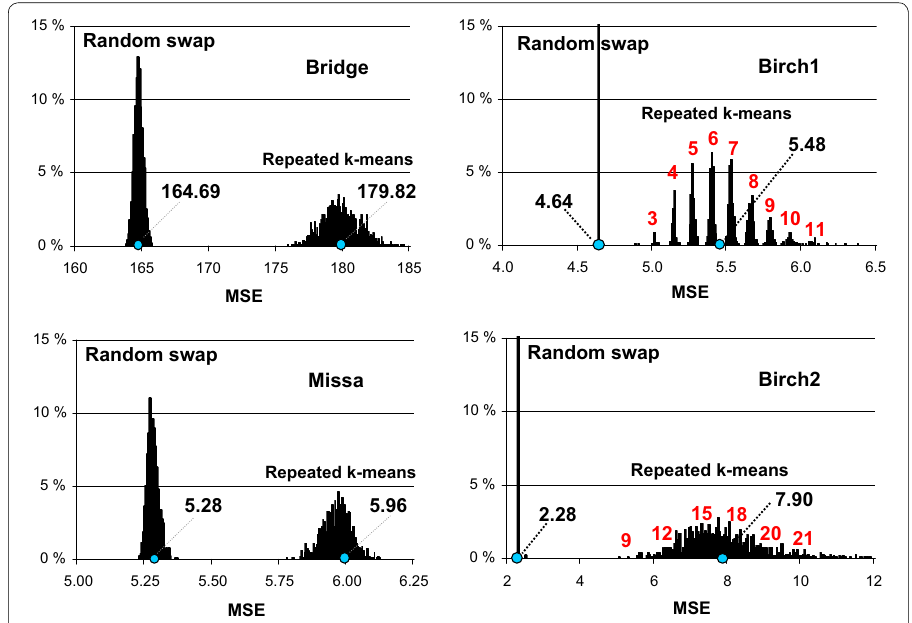
Fig. 17 Histograms of SSE-values for RS and RKM. CI-values are plotted by red font (when applicable) to approximate the number of incorrectly allocated prototypes (missing